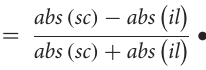
a moderate–good acceptance level. Further points are